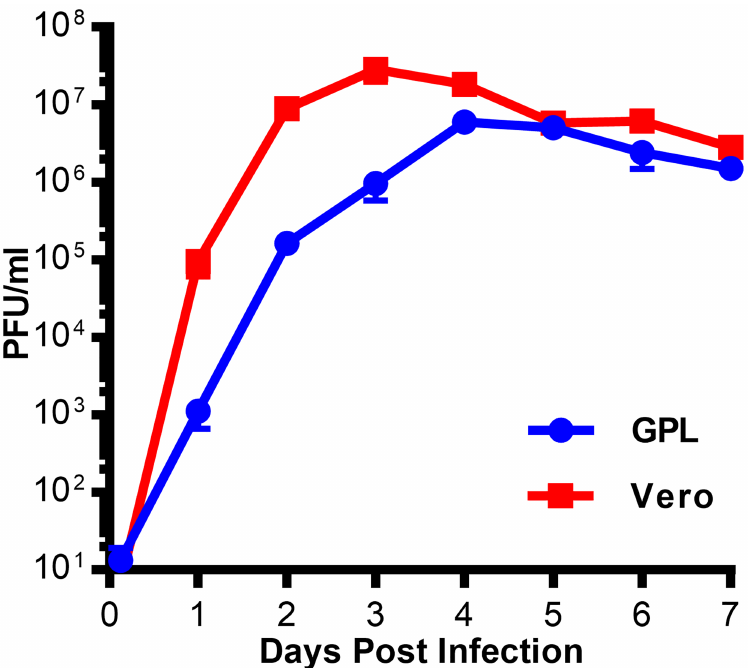
Fig 1. ZIKV infection of guinea pig cells in vitro . GPL and Vero cells were infected at a low MOI with ZIKV. Cell culture supernatant was collecteddaily and titered on Vero cells. The mean titer from three replicate infectionsis shown, and the bars representthe standard error for each set of